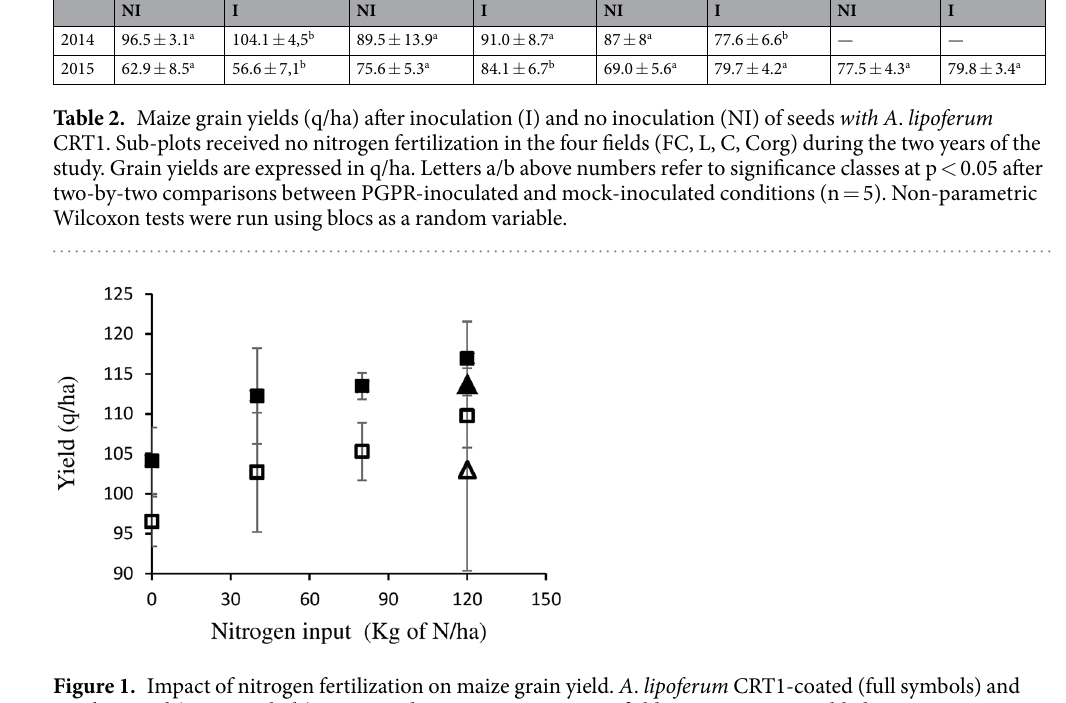
open source software R 35 with the RVAidememoire, mixOmics and ade4 packages (downloaded on march 2016).